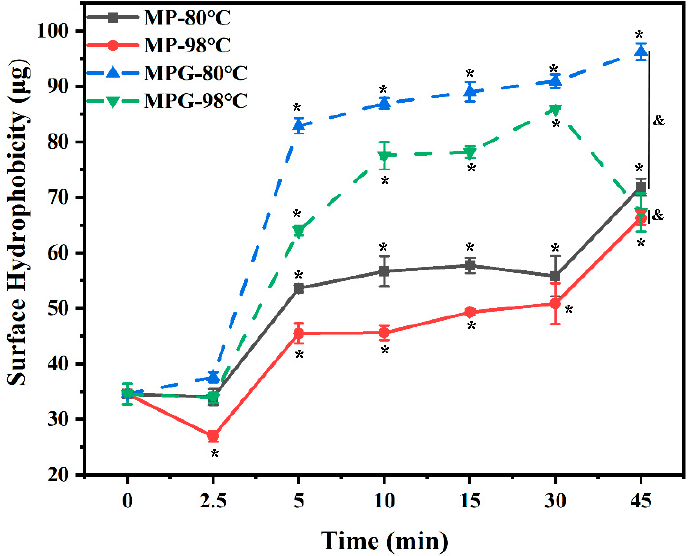
Figure 4. Changes in surface hydrophobicity of myofibrillar protein and glucose (MPG) and myofibrillar protein (MP) under different heating conditions (80 °C and 98 °C, 0 − 45 min). Error bars indicate standard deviation (n = 3). Samples with * p < 0.05 indicate significant differences at different heating times (compared with 0 min). Samples with & p < 0.05 indicate significant differences between MPG and MP.